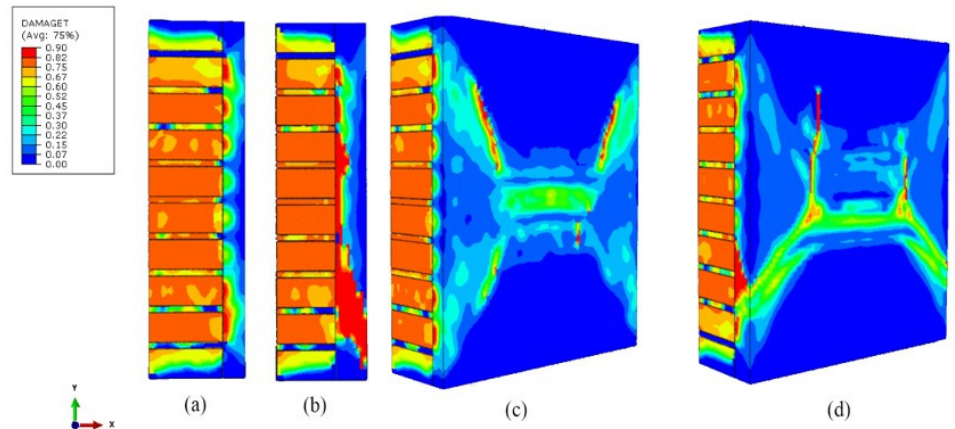
Figure 12. Damage performance in FE simulation results: ( a ) damages similar to failure mode II; ( b ) damages similar to failure mode I; ( c ) damages similar to failure mode B; and ( d ) damages similar to failure mode C.